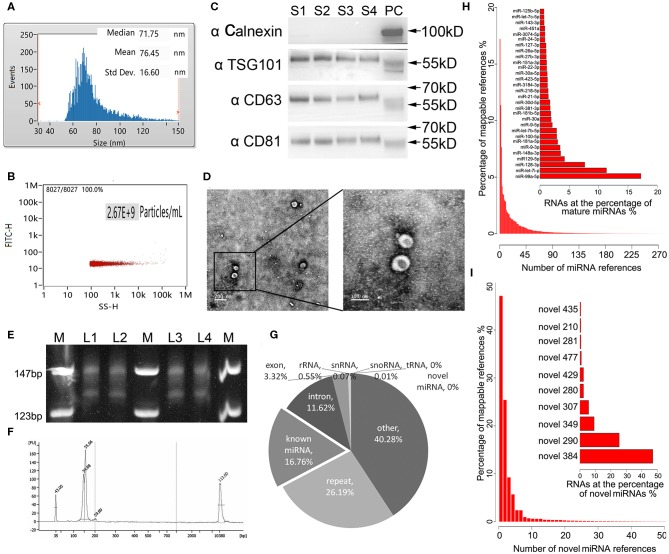
Technical pipeline for identification of plasma exosomal miRNAs by next-generation sequencing. (A) Representative size distribution of exosomes isolated from plasma determined using nano-flow cytometry. (B) Representative particle concentration of exosomes isolated from plasma determined by nano-flow cytometry. (C) Western blot showing the expression level of the typical exosome markers Calnexin (negative in exosomes), TSG-101, CD63, and CD81(positive in exosomes) in the four randomly selected exosomal samples from each group. S1–4, sample 1–4. PC, positive control using whole cell lysate prepared from HEK 293 cells. (D) Transmission electron microscopy picture showing the morphology of the exosomes. Scale bar on the left represents 200 nm, on the right 100 nm. (E) Polyacrylamide gel electrophoresis (PAGE) analysis for the established small RNA libraries. DNA ladders are shown in the 1st, 4th, and 7th lanes of the panel, while the DNA bands of prepared libraries are shown between the marker lanes. The anticipated size of the RNA sequencing constructs is ~150 bp. The DNA bands corresponding to 130 bp are the adaptor dimmers. M, DNA ladder. L1–4, library 1–4. (F) High-sensitivity DNA chip run on Agilent 2100 bioanalyzer demonstrates the quality and quantity of the gel-recovered library. (G) Illustrated RNA species and their abundance in the raw reads of exosomal RNA. Mappable reads are the sequences that are mapped to known human RNAs. lncRNA, long noncoding RNA; miRNA, microRNA; piRNA, piwi-interacting RNA; rRNA, ribosomal RNA; snRNA, small nuclear RNA; snoRNA, small nucleolar RNA; tRNA, transfer RNA. (H) Top 30 known miRNAs with the highest expression levels in exosomal miRNA libraries. (I) Top 10 novel miRNAs predicted by miRDeep2 and miREvo with the highest expression levels in exosomal miRNA libraries.